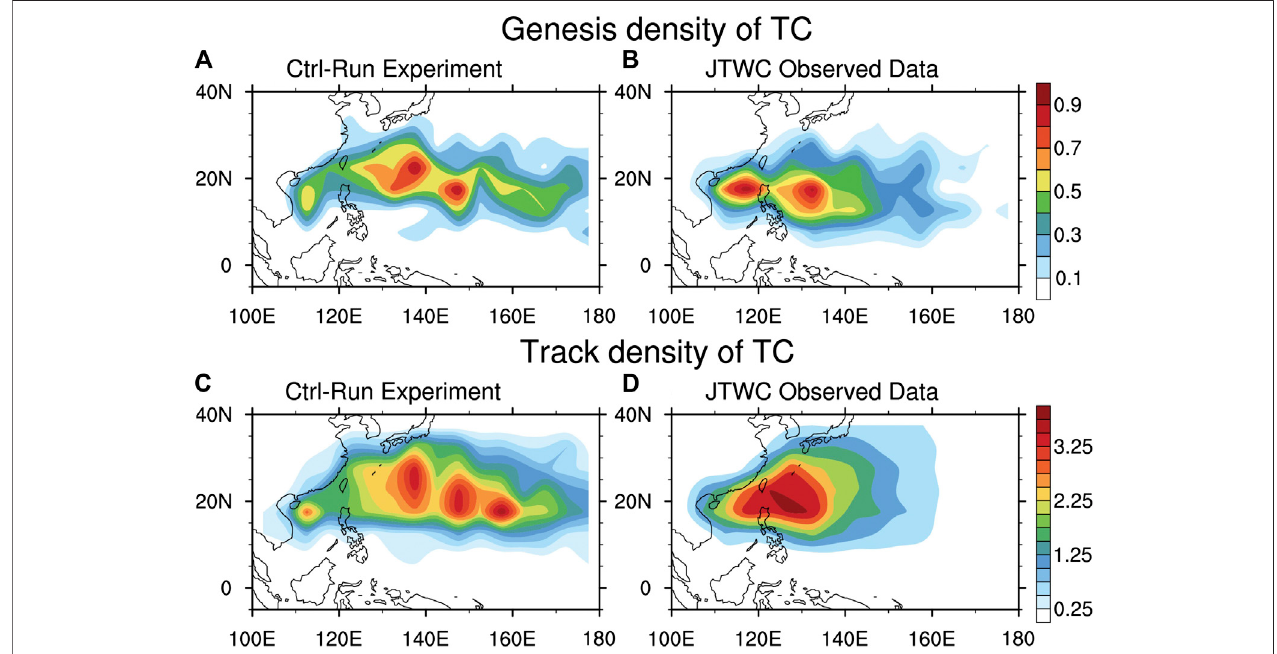
FIGURE 4 | Genesis density (A and B) and track density (C and D) of TCs per year during May to October. (A) and (C) are based on the 12-year control-run experiment and (B) and (D) are based on the JTWC observation data in 1991 – 2012.